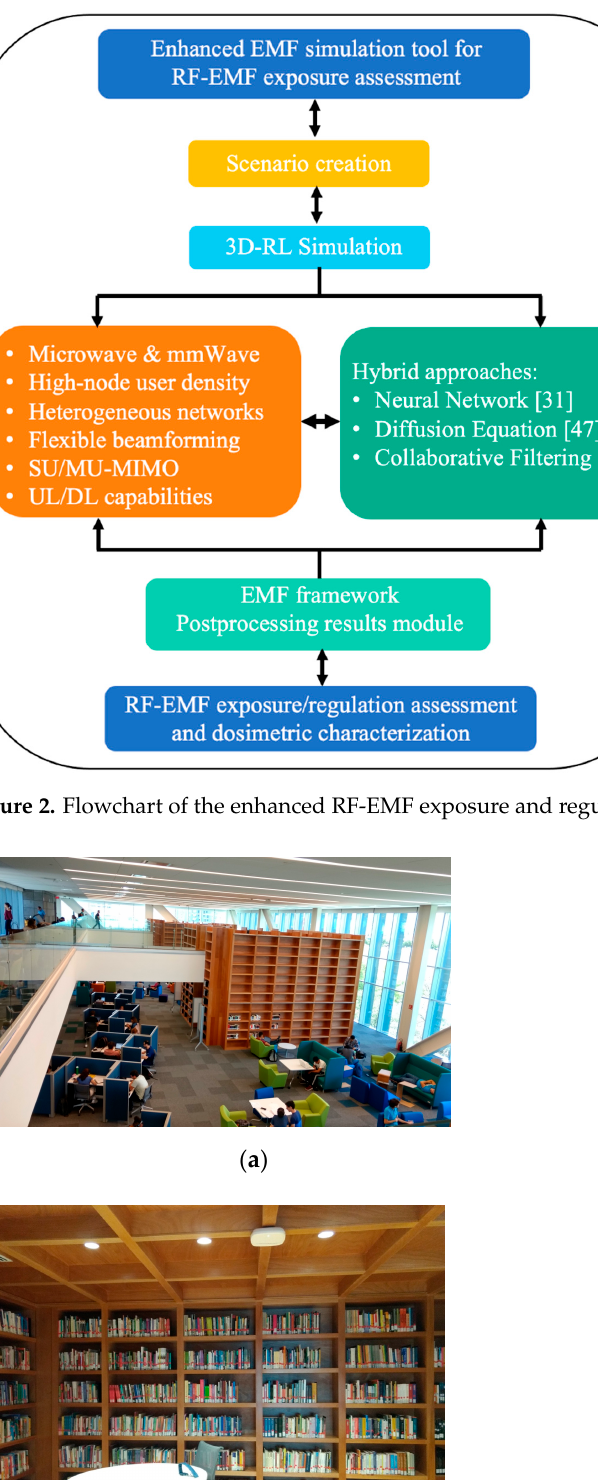
Figure 4. Rendered view of the simulated scenario by means of the 3D-RL technique. In the considered scenario, 9 Wi-Fi access points are currently installed, 6 of them located on the second-floor ceiling at a 6-m height and 3 more are placed within the work- spaces inside the wooden bookshelves. These access points can be seen in the central part of the ceiling shown in Figure 3. From an economical and aesthetic point of view, it is desirable to reuse existing in- door access point locations in the library as new communication systems are deployed in order to provide greater capacity, higher data rates and lower energy consumption in fu- ture networks. Thus, in the proposed future scenario, we have considered that the existing current Wi-Fi access points will be mounted co-sited with 9 mmWave gNodeB (gNB) hot spots operating at 5G-FR2 and 9 WLAN 802.11ay access points operating at 60 GHz. Fig- ure 5 presents a schematic overview of the locations of all these proposed access points.